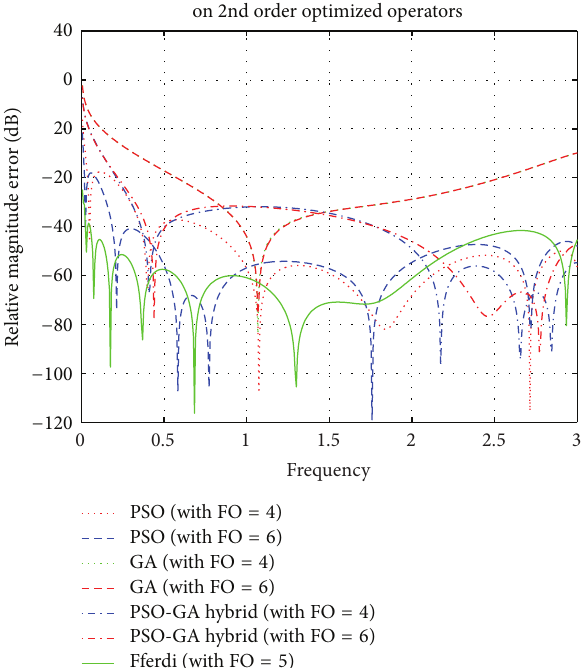
Figure7:Comparisonofrelativemagnitudeerrors(dB)ofproposed half differentiators based on 2nd order optimized differential oper-